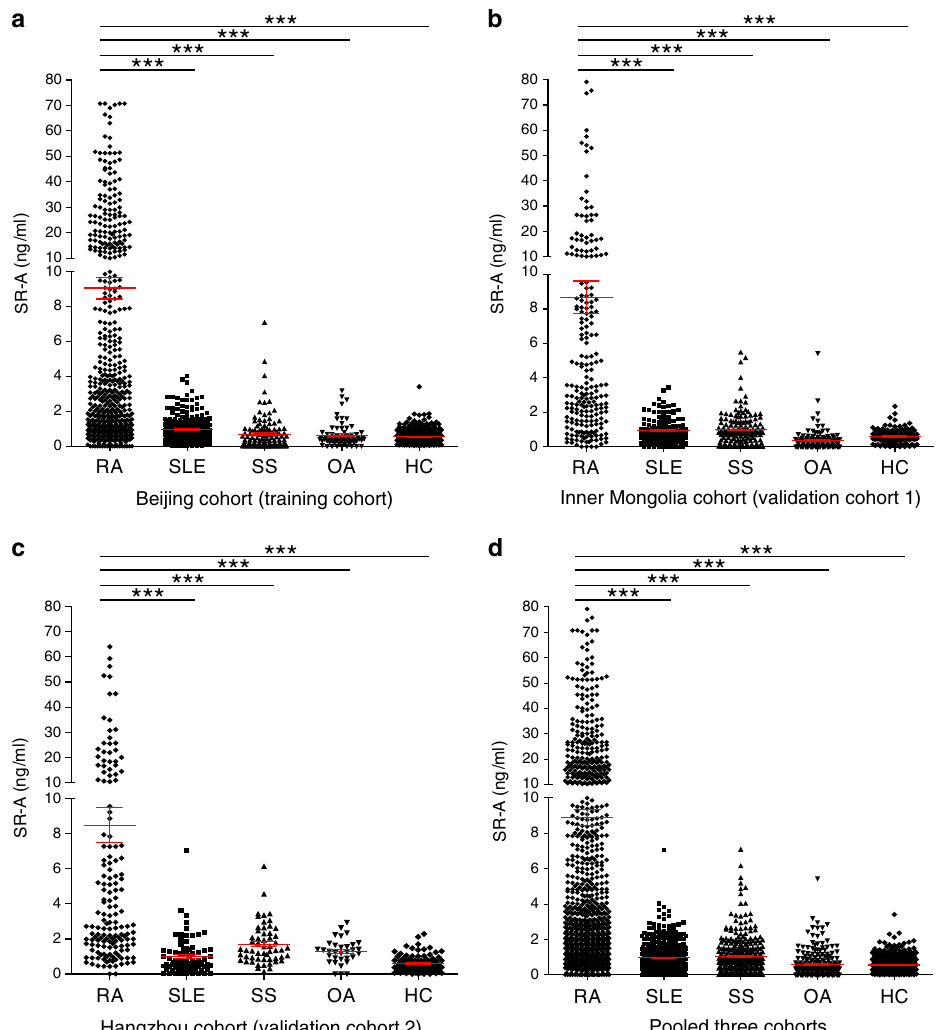
Fig. 2 Detection of sSR-A in a large-scale, multicenter study. A large-scale, multicenter study was performed to assess the discriminative power of serum sSR-A for RA using quantitative ELISA. The results of the training cohort, validation cohort 1, validation cohort 2, and the pooled three cohorts were shown, respectively. a Beijing cohort: training cohort (RA = 528; SLE = 254; SS = 120; OA = 72; HC = 480; ***all p < 1E − 15), b Inner Mongolia cohort: validation cohort 1 (RA = 213; SLE = 144; SS = 144; OA = 119; HC = 120; ***all p < 1E − 15), c Hangzhou cohort: validation cohort 2 (RA = 155; SLE = 80; SS = 55; OA = 32; HC = 100. *** p < 1E – 15, = 2.1799E − 04, = 5.9038E − 05, and <1E − 15, respectively, from left to right), d Pooled three cohorts: pooled all three cohorts ’ data together (***all p < 1E − 15). Red horizontal lines: means; error bars: SEMs. *** p < 0.001 (Kruskal – Wallis test followed by Dunn ’ s posttest for multiple comparisons). Source data are provided as a Source Data fi